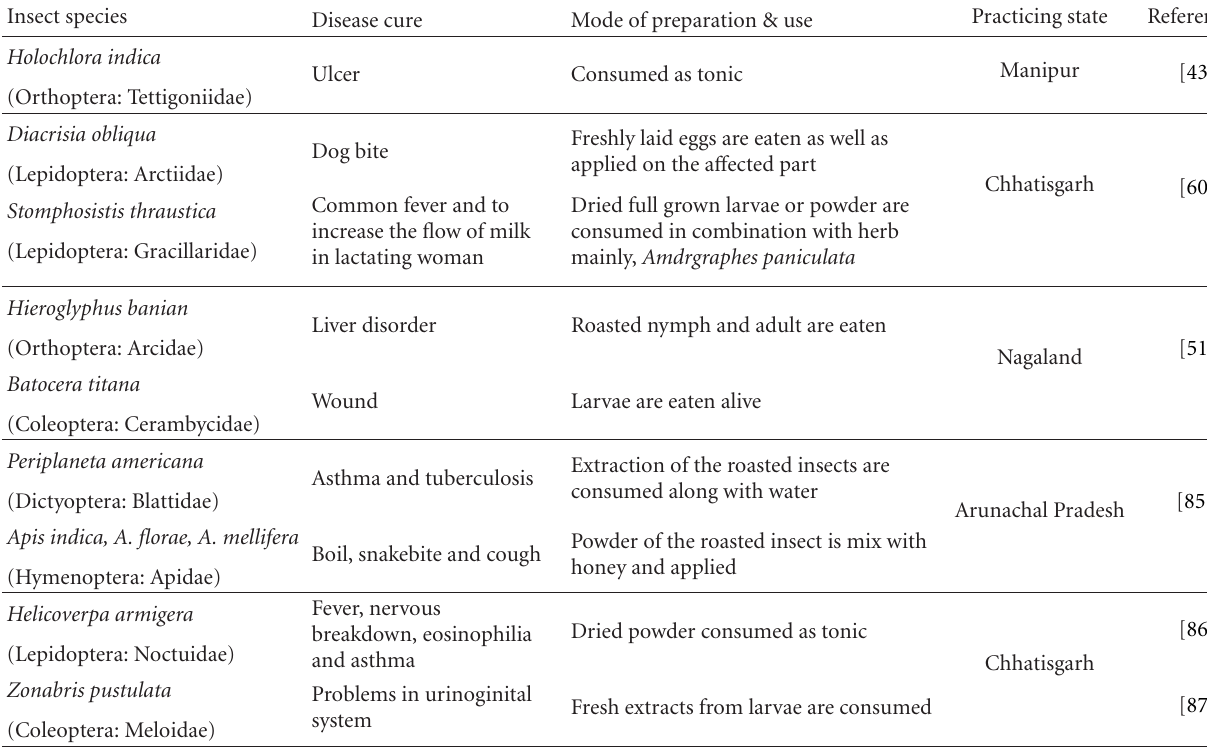
Table 5: Insects used in Indian traditional